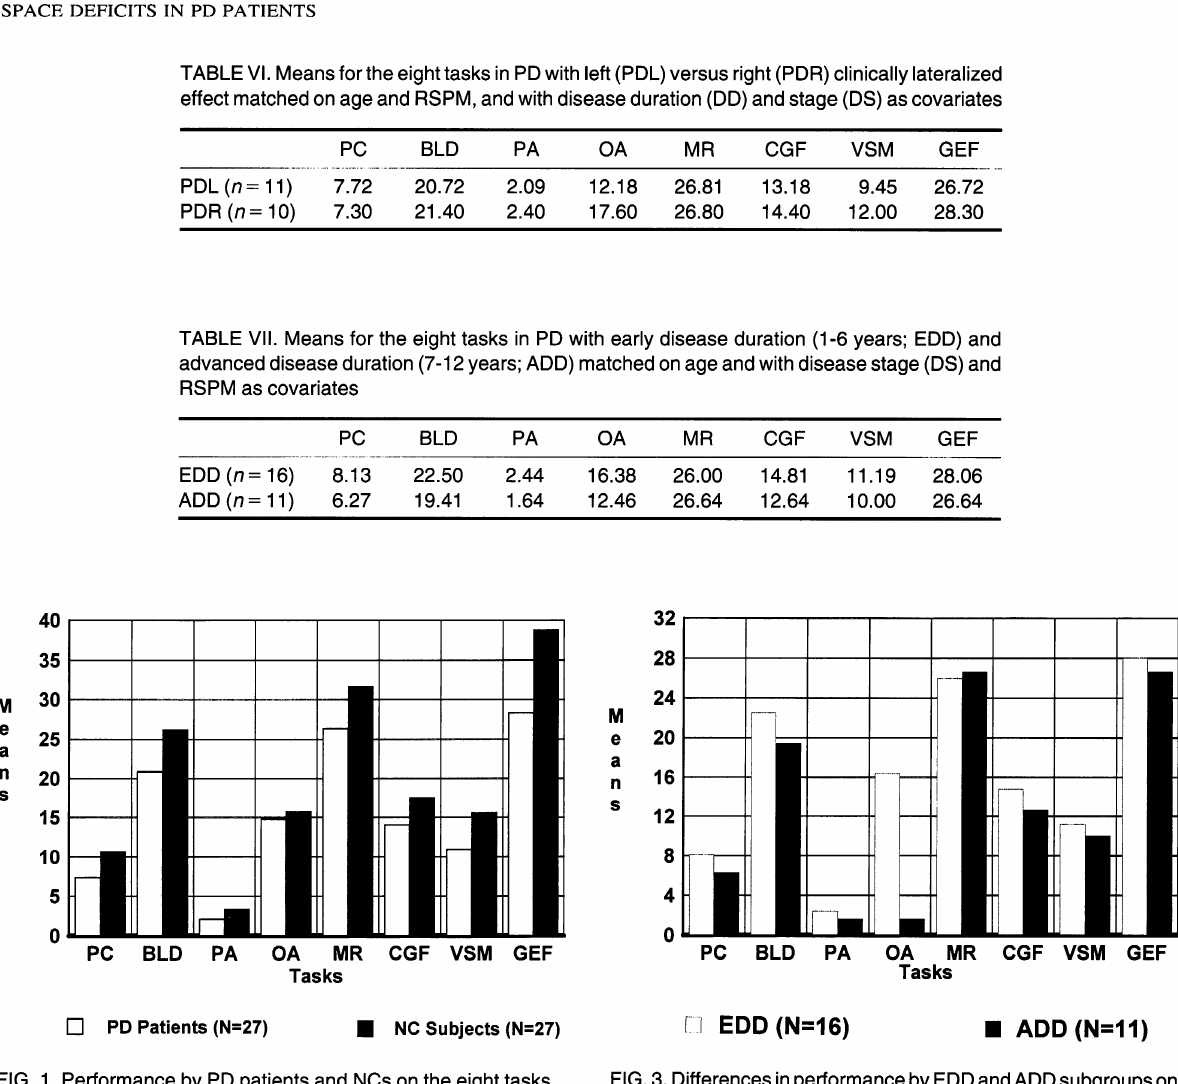
[X 2 (51) = 28.656, p = 0.9952] and goodness of fit [X 2 (51) = 29.439,p = 0.9933], with all of the independent variables indicate that the present model does not differ significantly from the perfect model, i.e. from